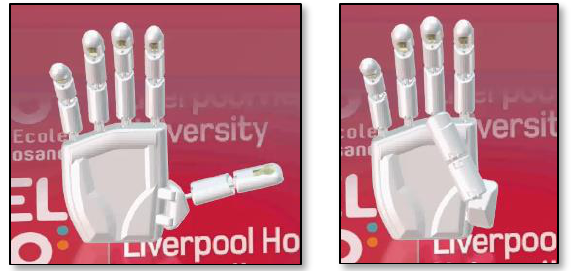
Figure 3. Thumb extension and flexion.